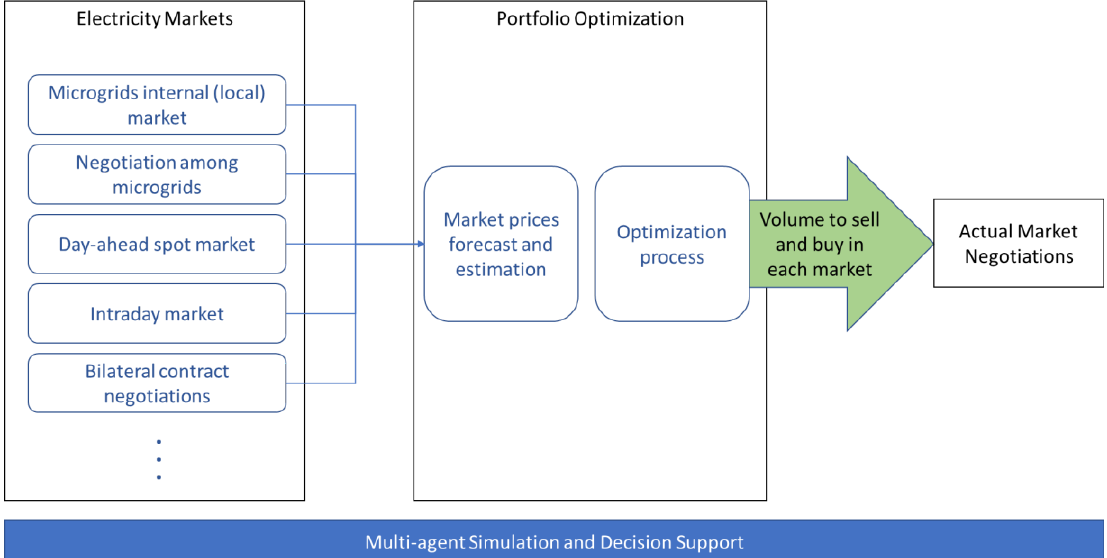
Figure 1. General overview of the proposed methodology.